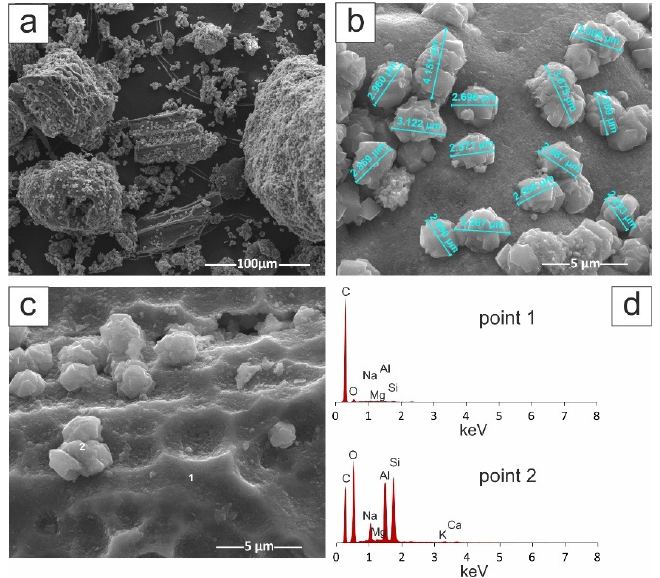
Figure 2. SEM images of Na-X(C) sample: ( a ) 1000× magnification, ( b ) 16,000× magnification, ( c )